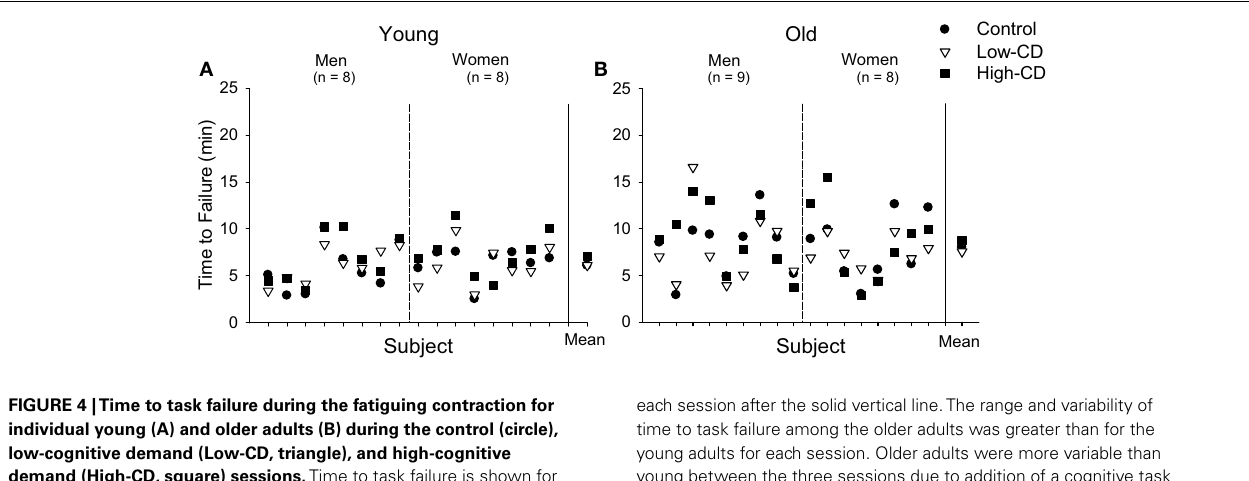
FIGURE 4 |Time to task failure during the fatiguing contraction for individual young (A) and older adults (B) during the control (circle), low-cognitive demand (Low-CD, triangle), and high-cognitive demand (High-CD, square) sessions. Time to task failure is shown for each young (A) and older (B) man and woman for each session (separated by dashed line).The aggregate mean ( ± SE) is shown for